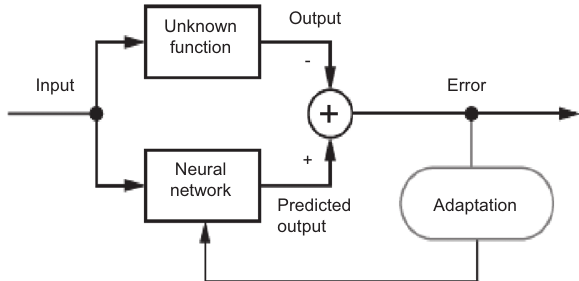
Figure 3. Neural Networks as Function